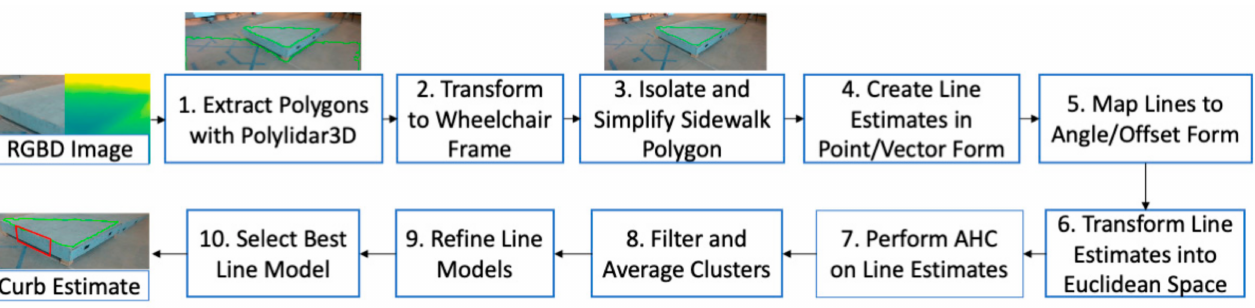
Figure 6. Procedure for extracting a curb estimate from an RGBD image.